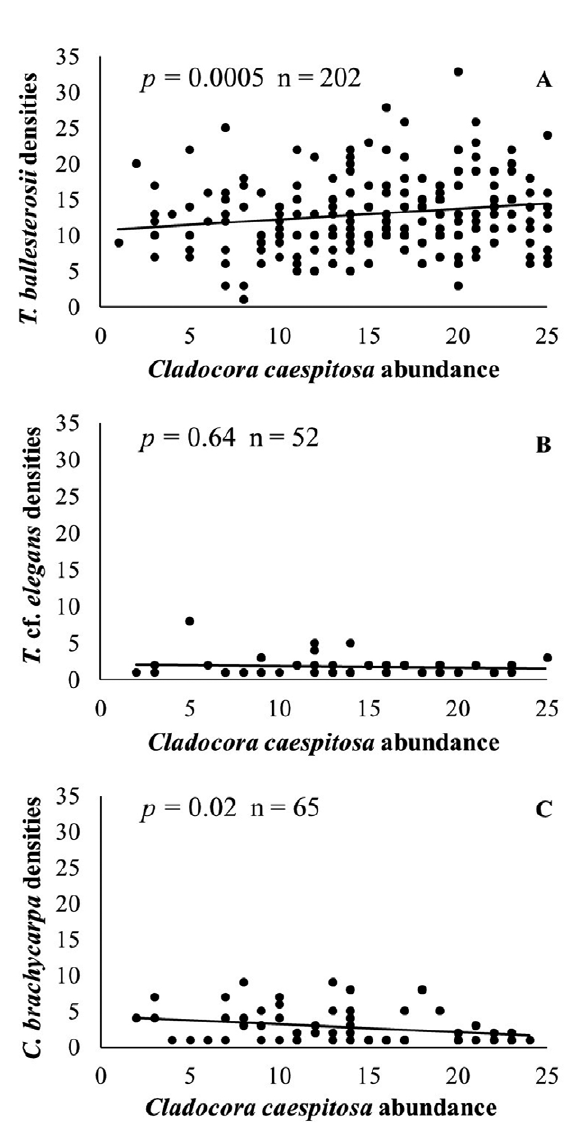
(C).Fig. 6. – Size frequency distribution of Treptacantha cf. elegans Fig. 7. – Relationship between the densities of the different species starting at the class interval of 1 cm (main axes measuring 0.1-1 of Cystoseira s.l. and Cladocora caespitosa abundance: Treptacan- cm) tha ballesterosii (A), Treptacantha cf. elegans (B) and Carpodesmia brachycarpa